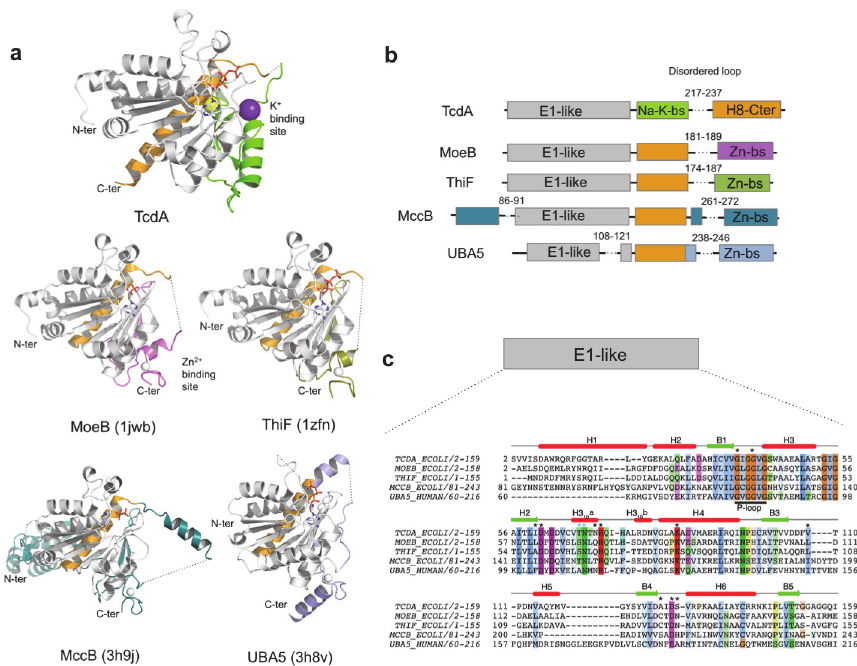
Fig 5. Structural comparison of TcdA with the homologous E1-like activating enzymes. a Ribbon representation of TcdA structural homologs found with PDBeFold [51] with structural similarity Q-scores higher than 0.28 (the highest Q-scores are 0.49 with MoeB and 0.46 with ThiF). All structures were superimposed onto TcdA and are shown in similar orientations for comparison: MoeB (PDB 1JWB), ThiF (PDB 1ZFN), MccB (PDB 3H9J) and UBA5 (PDB 3H8V). E1-like core domain is shown in grey; the long α - helix that is structurally equivalent to TcdA α 8 is in orange; metal binding sites are in protein-specific colors; K + ions are in purple, Na + ions in yellow, and Zn 2+ in grey. b Schematic representation of the domain architecture of the E1-like enzymes superimposed in ( a ), with equivalent color coding; bs, binding site; the sequence position corresponding with disordered loops is indicated by dashed lines and marked with start and end residues. The C-terminal α 8 helix in TcdA is structurally equivalent to the α -helix immediately following the E1-like domain in the other enzymes. c Structure-guided multiple sequence alignment of the E1-like domain with overlaid secondary structure from TcdA. Functionally important residues and motifs are annotated as follows: bold underline, P-loop residues; black asterisks, residues in direct contact with ATP; and blue asterisks, residues from helix H3 10 a that make water-mediated contacts with the nucleotide. Conserved residues are shown in shaded